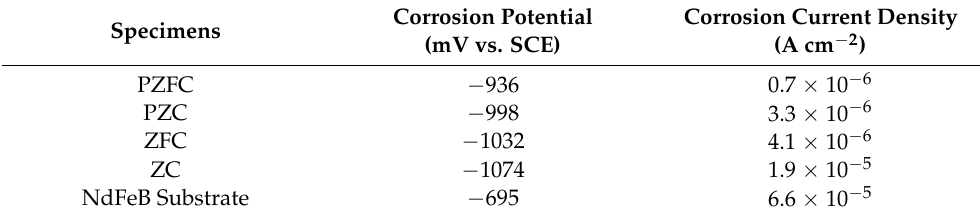
Table 3. Electrochemical parameters calculated from polarization curves.